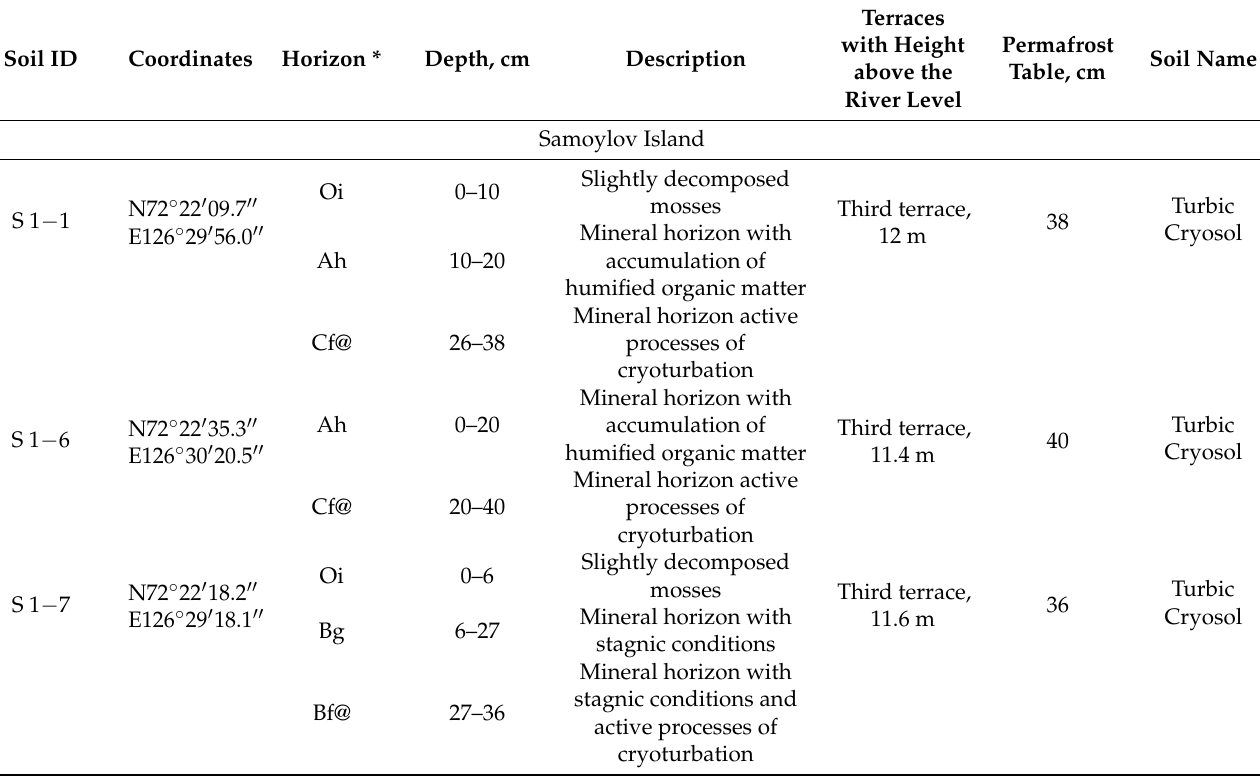
Figure 2. Study soils of the Lena River Delta. Table 1. Description of Study Soils.